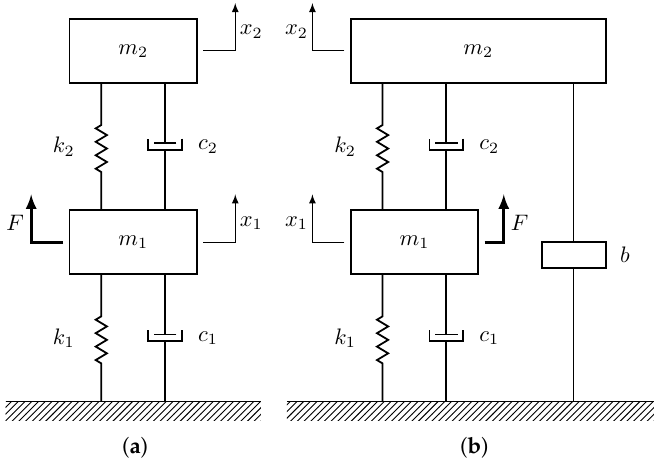
Figure 1. Schematic diagram of an SDOF mechanical system controlled by ( a ) a TMD and ( b ) a TMDI. An external force F acts directly on the vibrating mass of the primary